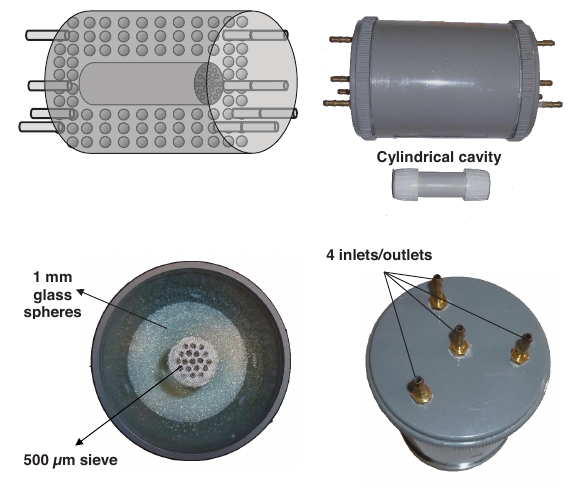
Figure 1. A Model Heterogeneous Porous Medium (MHPM).